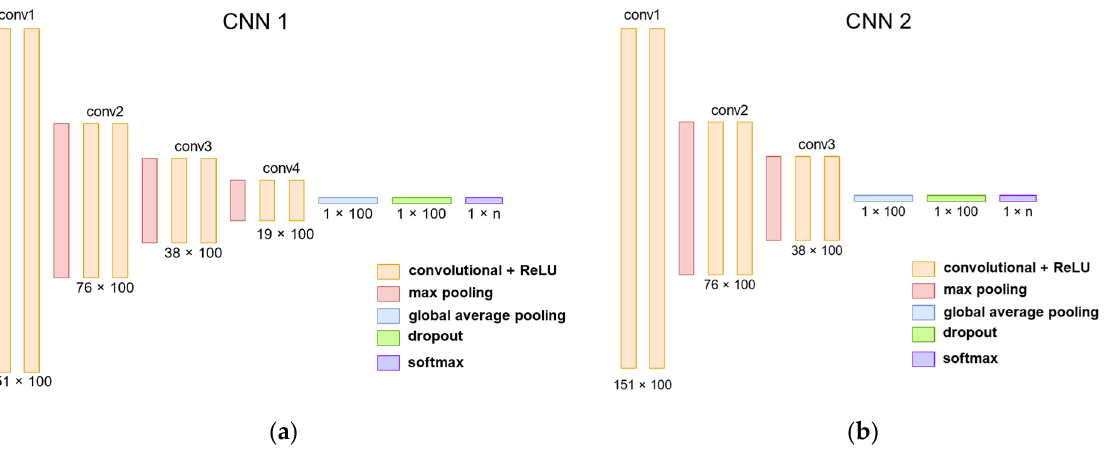
Figure 4. The CNN architectures implemented with TensorFlow 2. ( a ) CNN1 architecture with 4 convolutional blocks. ( b ) CNN2 architecture with 3 convolutional